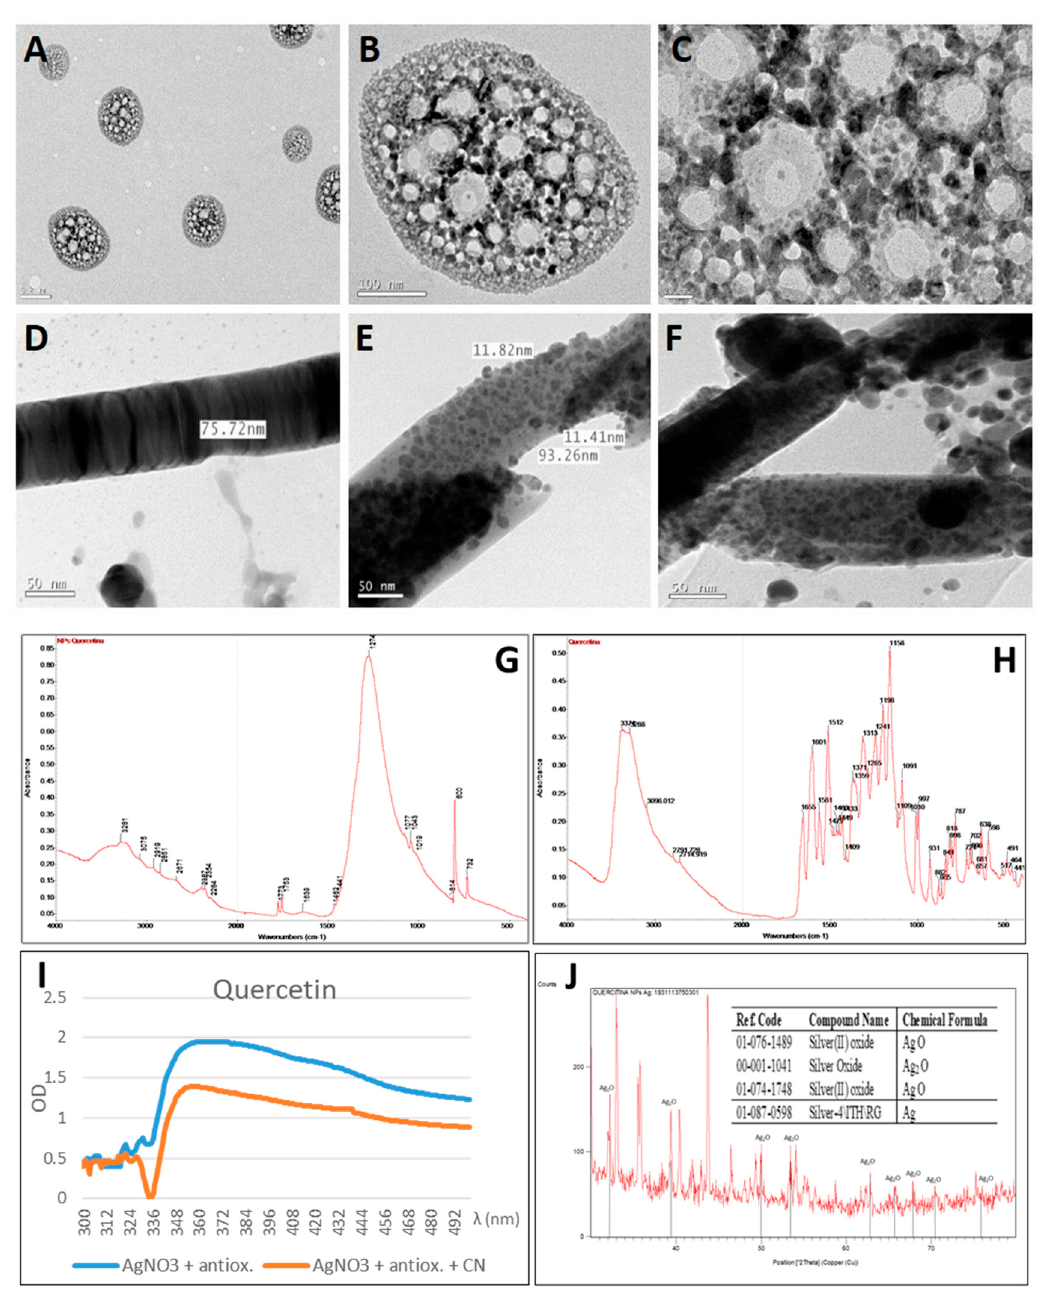
Figure 3. Analysis of quercetin-synthesised silver nanoparticles (AgNP). ( A – C ) images of AgNPs obtained by transmission electron microscopy (TEM). ( A ) Micelle-like structures. ( B ) Micellar structure detail. ( C ) Detail of vesicles located between the silver nanoparticles. ( D – F ) TEM images of AgNPs after cyanide addition. ( D ) rod-like structure. ( E ) Detail of filament showing the aggregation of the nanoparticles. ( F ) Detail of rod-like structures with their size diameter and comparison with the size of the nanoparticles. ( G ) Fourier transform infrared (FTIR) spectrum of quercetin-derived nanoparticles. ( H ) FTIR spectrum of quercetin. ( I ) Ultraviolet (UV)-visible AgNP spectra prepared with quercetin and AgNO 3 prior (blue line) and after (orange line) cyanide addition. ( J ) X-ray diffraction (XRD) profile of AgNPs obtained by quercetin reaction with AgNO 3 (an identification table has been inserted). Peaks identifying the presence of silver oxides have been indicated in the XRD diffractogram.